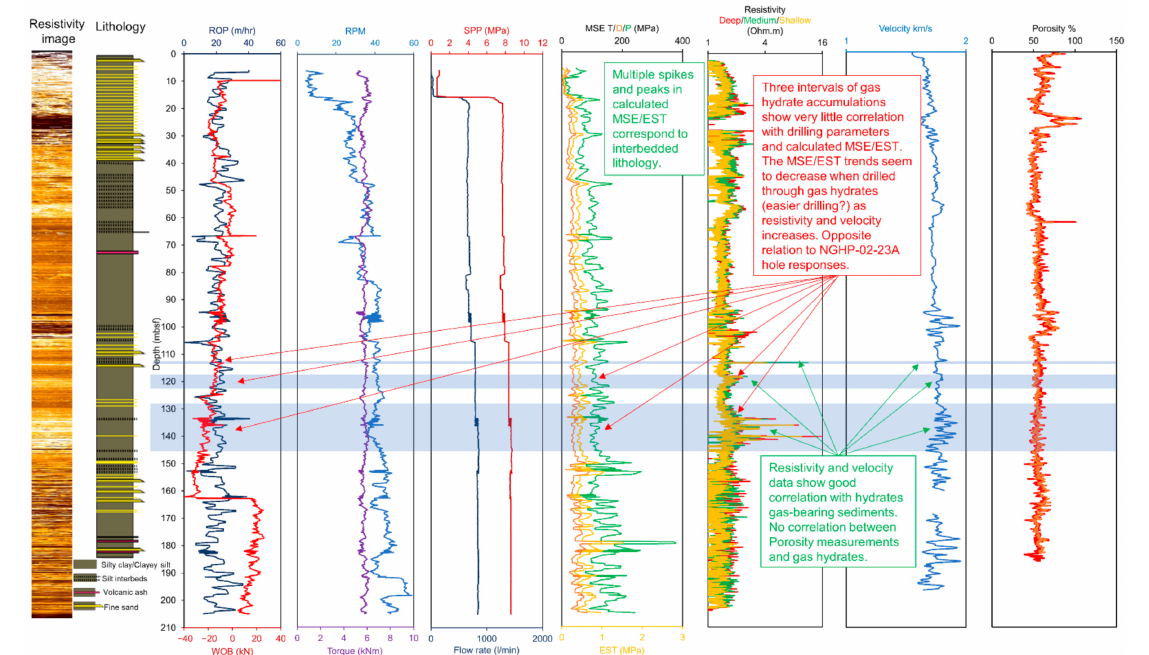
Figure 13. Depth-based drilling data series for wellbore U1517A correlated with image log and lithology column ( left side of the plot), resistivity, sonic, and porosity data ( right side). Shaded areas present the three gas hydrate intervals detected in the wellbore by MWD/LWD logging